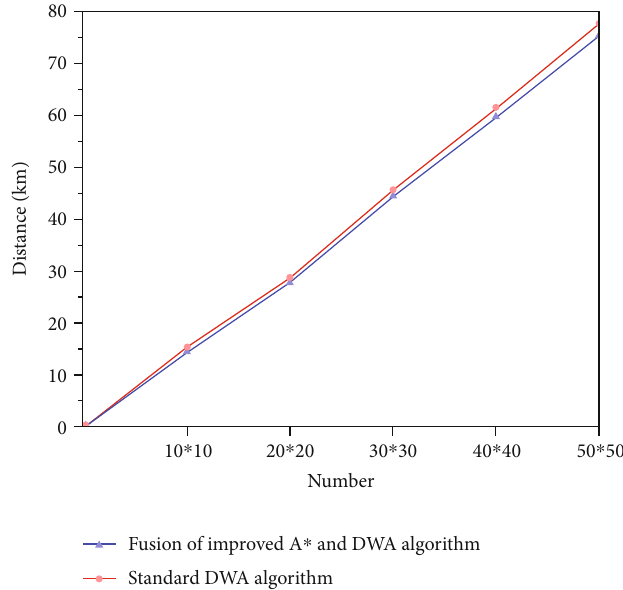
Figure 12: The relationship between the map size and the length of the paths yielded by the two algorithms.